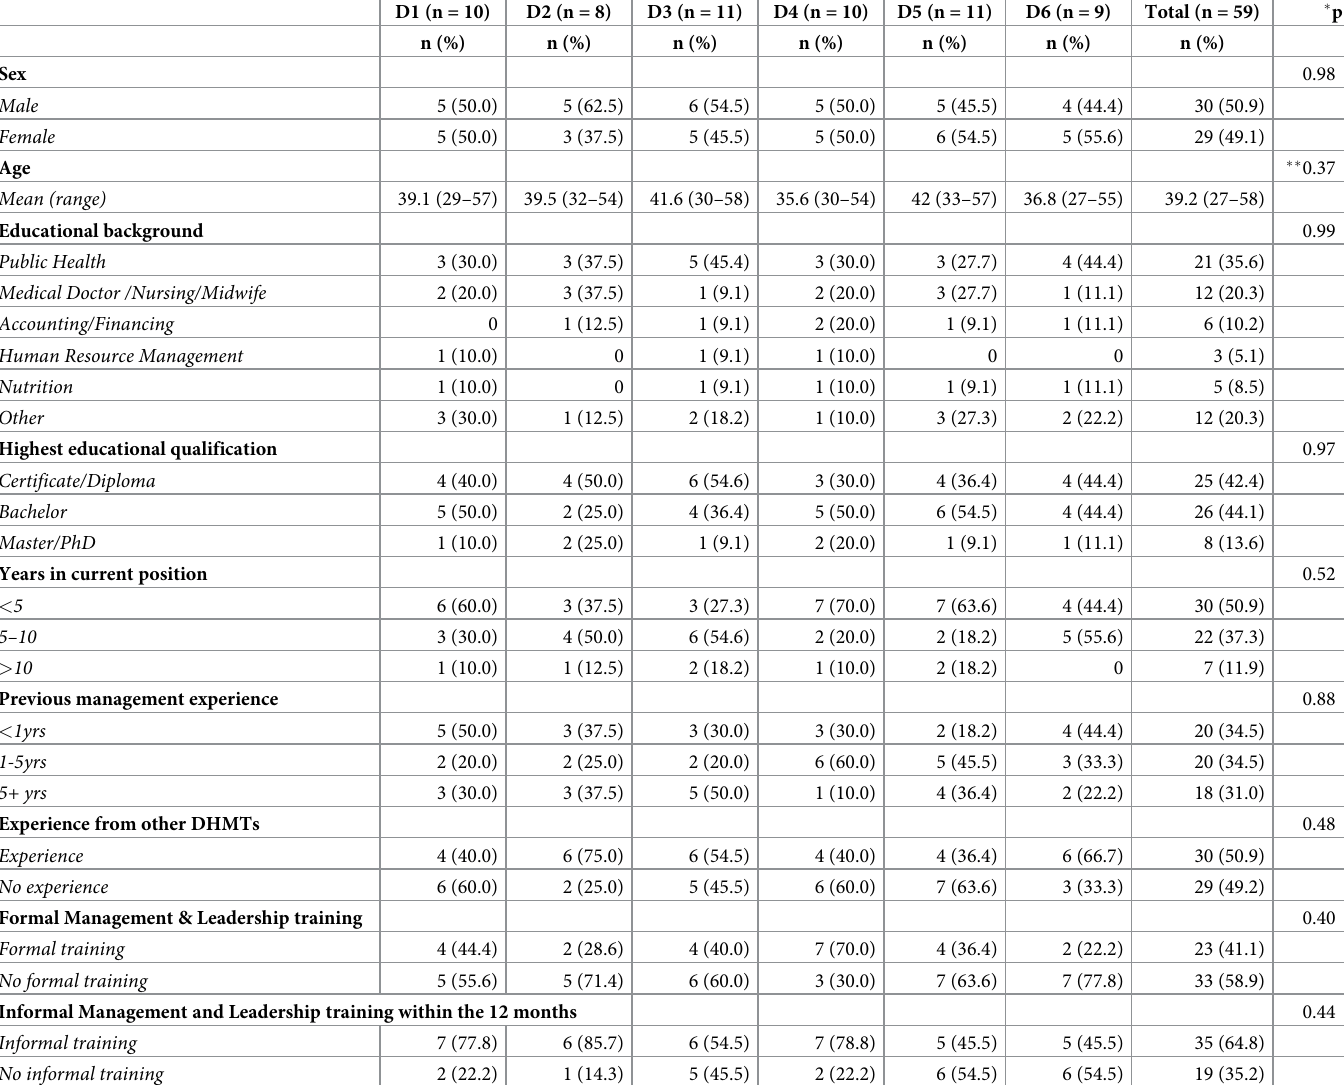
Table 3. Characteristics of study participants across different performing